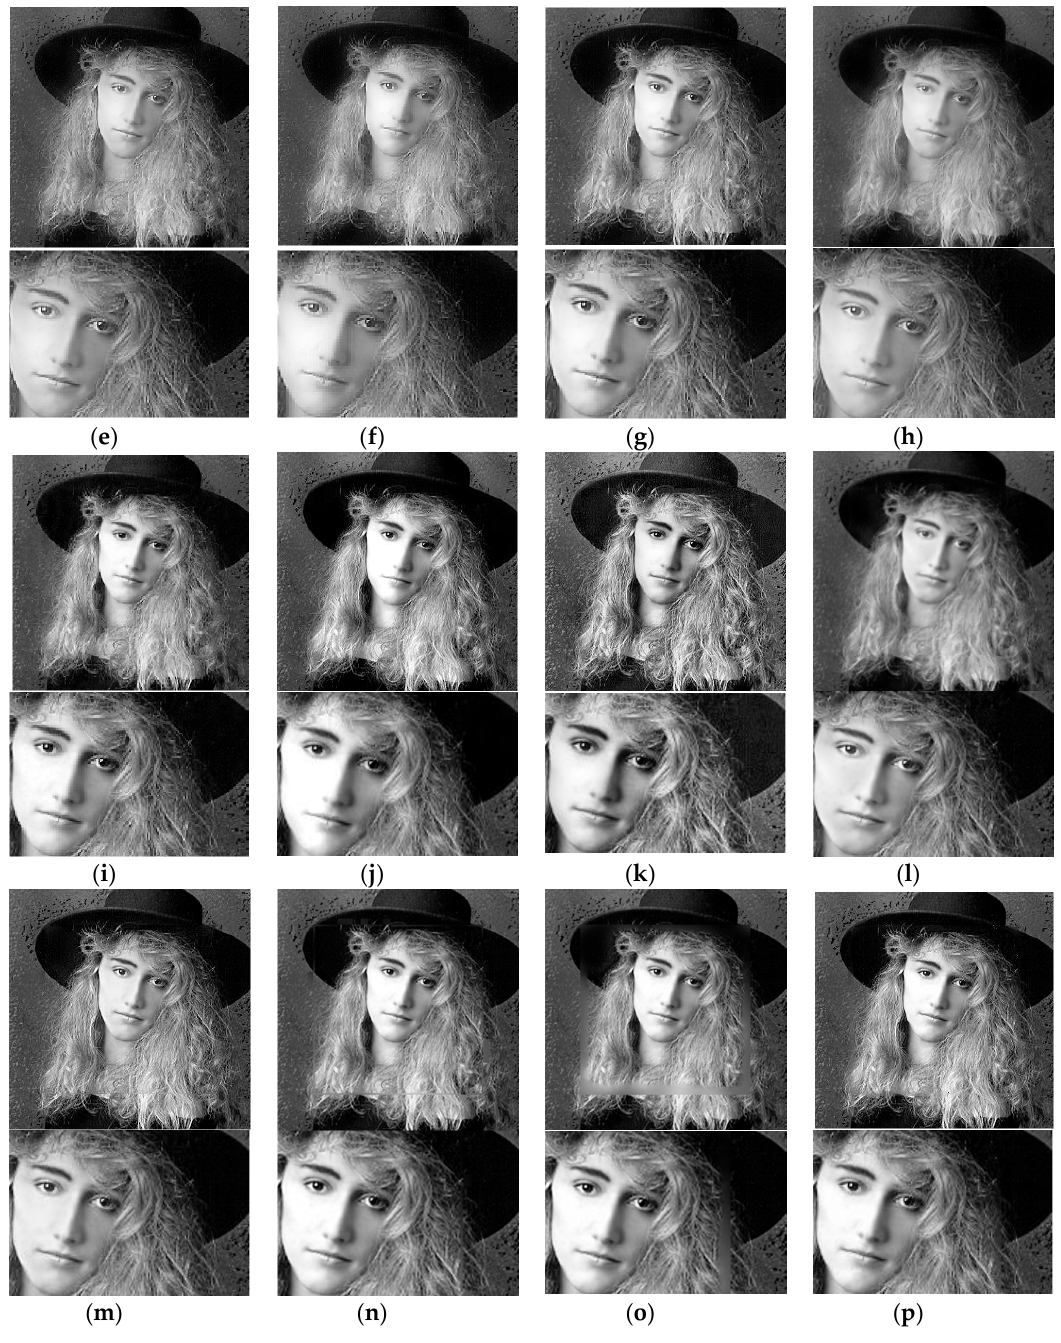
Figure 5. Fused images obtained by different methods in the image pair “head”. ( a ) principal component analysis (PCA); ( b ) single-scale PCA-based weight (SWPCA); ( c ) multiscale weighted PCA (MWPCA); ( d ) discrete wavelet transform (DWT); ( e ) gradient pyramid (GP); ( f ) multi- resolution singular value decomposition (MSVD); ( g ) convolutional sparse representation (CSR); ( h ) fsd pyramid (FSD); ( i ) discrete cosine harmonic wavelet transform (DCHWT; ( j ) multi-scale guided image and video fusion (MGFF); ( k ) multi-exposure and multi-focus image fusion in gradient domain (MMGD); ( l ) stationary wavelet transform (SWT); ( m ) Laplacian pyramid transform and pulse coupled neural networks (LPPCNN); ( n ) boosted random walks-based algorithm (BRWIF); ( o ) fourth order partial differential equations (FPED); ( p ) support vector machine (SVM)-MWPCA.